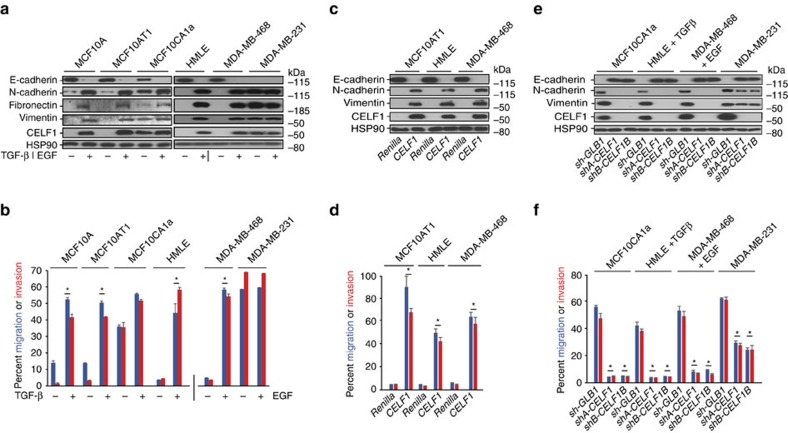
CELF1 expression and function are conserved in multiple cellular models of EMT.(a) Immunoblot analysis of indicated epithelial and mesenchymal cell markers and CELF1 in untreated or TGF-β-treated MCF10A, MCF10AT1, MCF10CA1a and HMLE cells, and in untreated or EGF-treated MDA-MB-468 and MDA-MB-231 cells. HSP90 serves as a loading control. (b) Quantification of cellular migration and invasion in transwell assays in untreated or TGF-β-treated MCF10A, MCF10AT1, MCF10CA1a and HMLE cells, and in untreated or EGF-treated MDA-MB-468 and MDA-MB-231 cells. (c,d) As in a and b, but in response to stable Renilla Luciferase or CELF1 overexpression in the indicated cell lines, respectively. In c, HSP90 serves as a loading control. (e,f) As in a and b, but in response to stable knockdown of β-galactosidase (shGLB1) or two distinct CELF1 shRNAs (shCELF1A, shCELF1B) in the indicated cell lines, respectively. In e, HSP90 serves as a loading control. All panels are representative of a minimum of three individual experimental replicates. For immunoblots depicted, samples were derived from the same experiment and gels were processed in parallel. Error bars depict s.d. of the mean. *P≤0.05 (Student's t-test). See also Supplementary Fig. 4. Full scans of blots are shown in Supplementary Fig. 11.